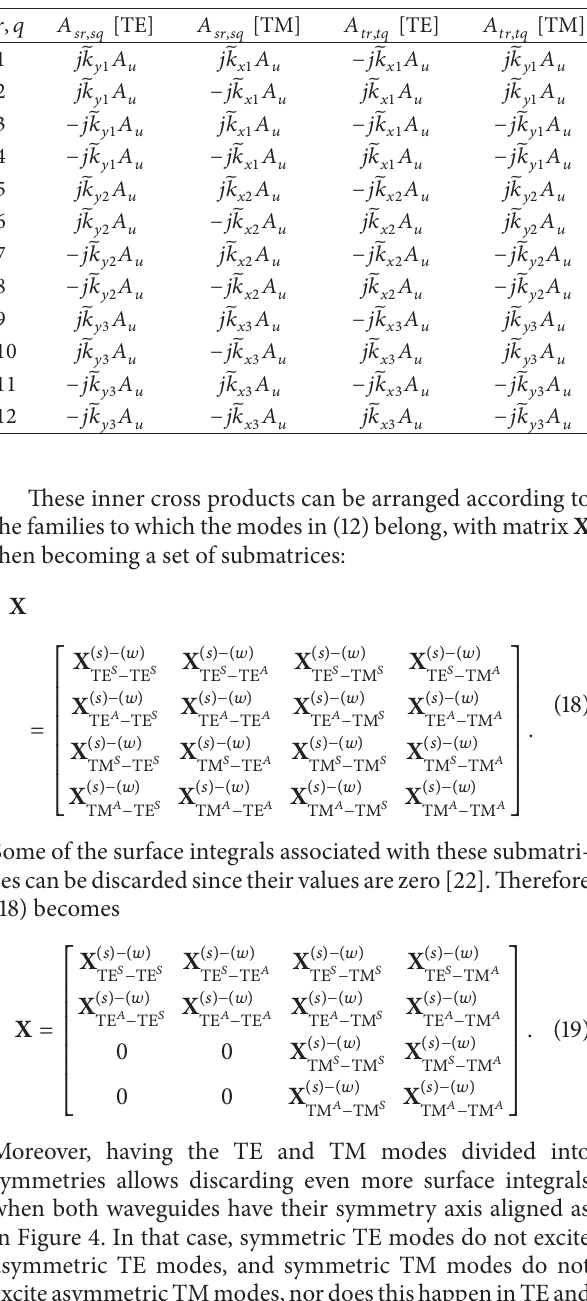
Table 4: Values of parameters 𝐴 𝑠𝑟 , 𝐴 𝑠𝑞 , 𝐴 𝑡𝑟 , and 𝐴 𝑡𝑞 .